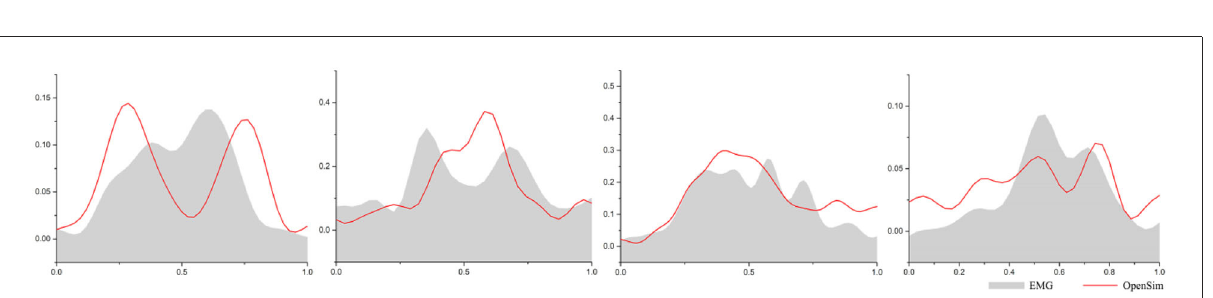
FIGURE3 Comparison of rectus femoris, gastrocnemius, biceps femoris, and tibialis anterior muscle activation level obtained by EMG signal and OpenSim optimization